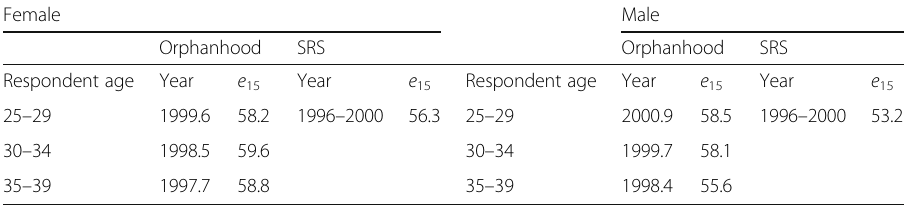
Table 3 Comparison of ( e 15 ) by gender from orphanhood method and SRS, India Female Male Orphanhood SRS Orphanhood SRS Respondent